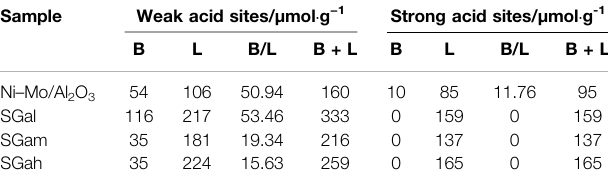
TABLE 4 | Acidity properties of impregnated Ga-modi fi ed Ni – Mo/Al 2 O 3.